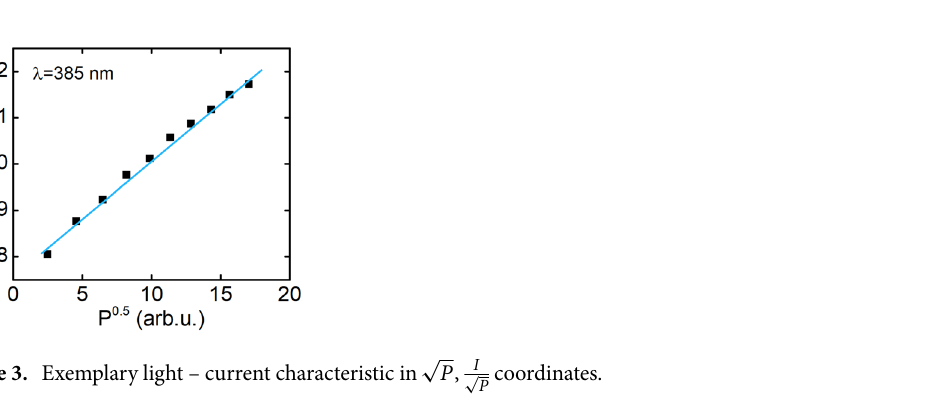
Figure 2. Ratio of electroluminescence signal obtained for laser diode structures grown on bulk GaN and sapphire, emitting in the range from λ = 383 nm to λ = 477 nm.